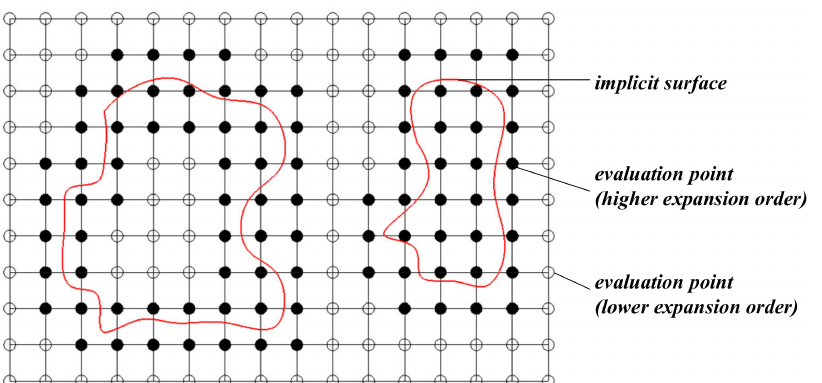
Figure 3. The evaluation process using the signed marching cubes method. The evaluation points are divided into two categories, including the points evaluated with a higher expansion order and the points evaluated with a lower expansion